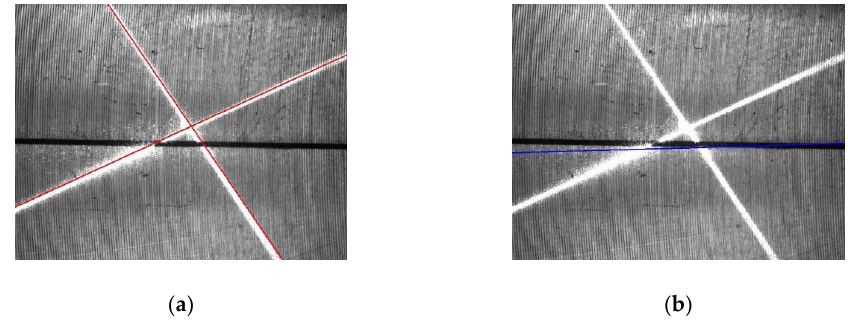
Figure 9. Extracted lines with the rough Hough transform. ( a ) Laser stripe lines. ( b ) Joint line.